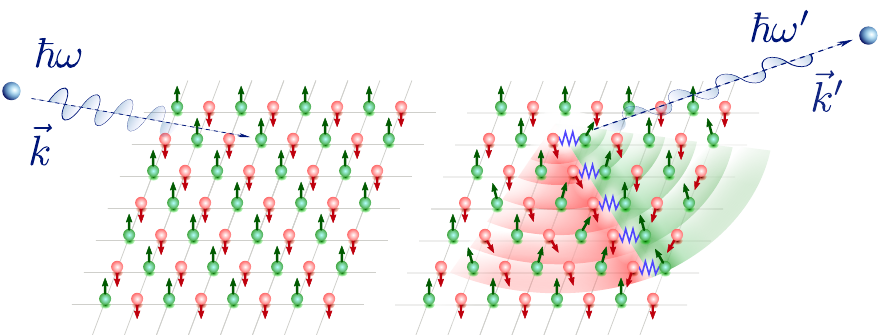
Figure 1: Sketch of a scattering event. By inelastic scattering of a neutron in the longitudinal channel two magnons are excited from the long-range ordered antiferromagnetic ground state. On short distances, they interact strongly and attract each other forming resonances [ 18 ] . Note that the magnons are sketched here as wave packets localized in real and in reciprocal space with a finite minimum uncertainty as required by Heisenberg’s uncertainty